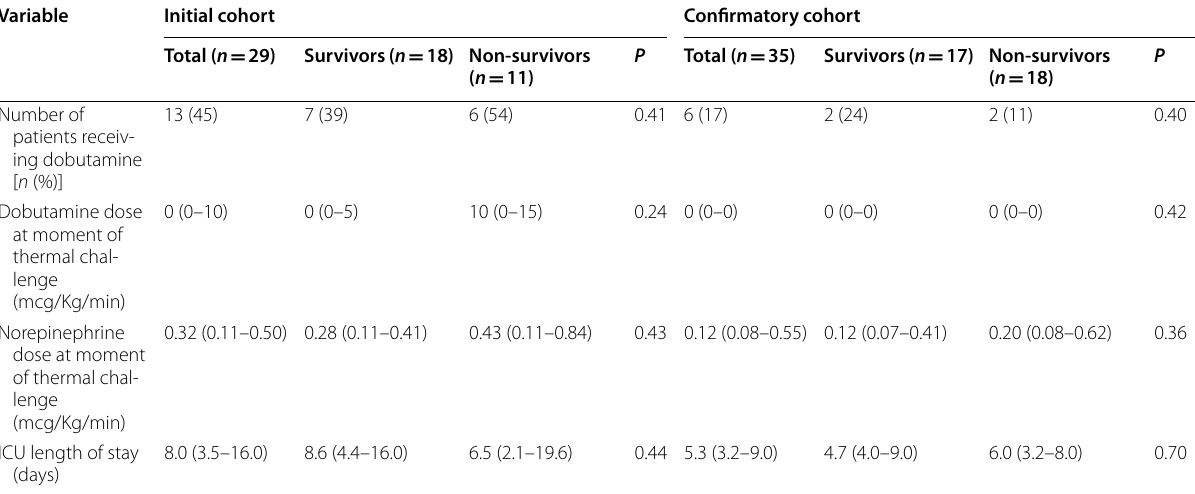
Table 2 Comparison of skin laser Doppler (SLD) variables between volunteers and patients and between survivors and non-survivors